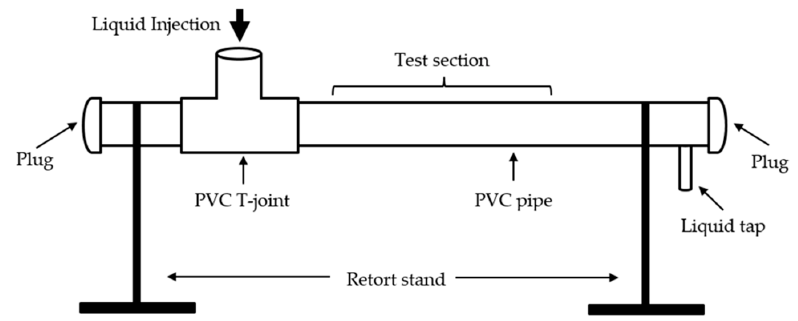
Figure 11. Schematic illustration of experimental setup for two-phase flow.